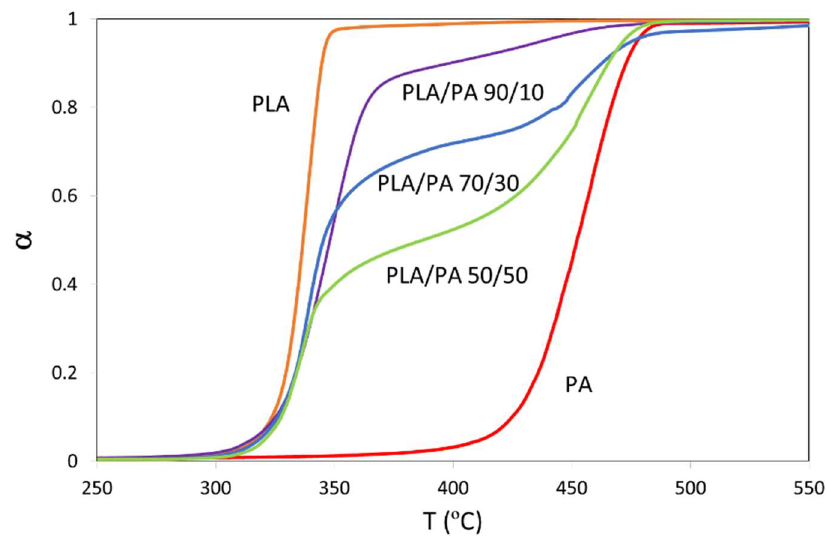
Figure 3. Variation of conversion with temperature for PLA and PA neat polymers, and the bioblends containing 90, 70, and 50% of PLA, without previous reactive extrusion of PLA, with a nominal heating rate of 10 K/min.